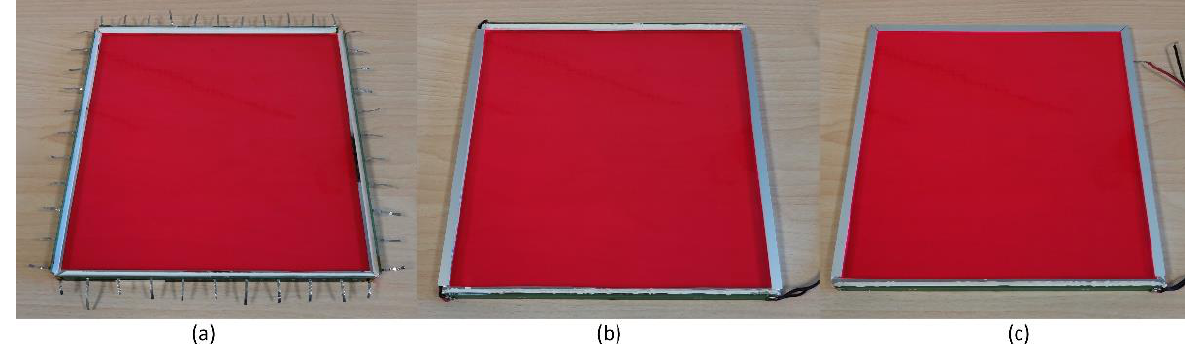
Figure 4. ( a ) Picture of the prototype with four PV arrays, configured to measure the current produced by each cell. ( b ) Picture of the prototype with two PV arrays, configured to measure the power produced by the module. ( c ) Picture of the prototype with one PV array, configured to measure the power produced by the module.